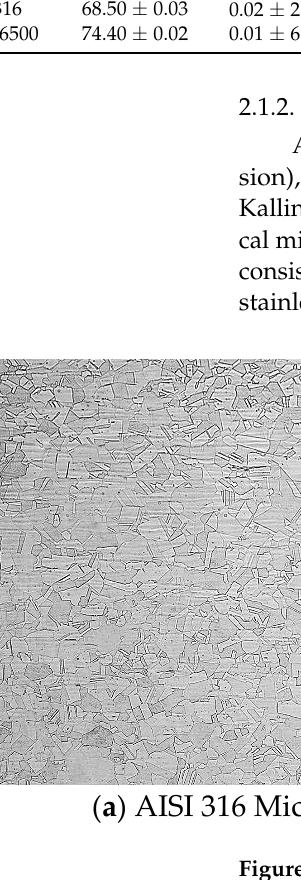
Table 1. Chemical composition of analyzed steels (in wt %).